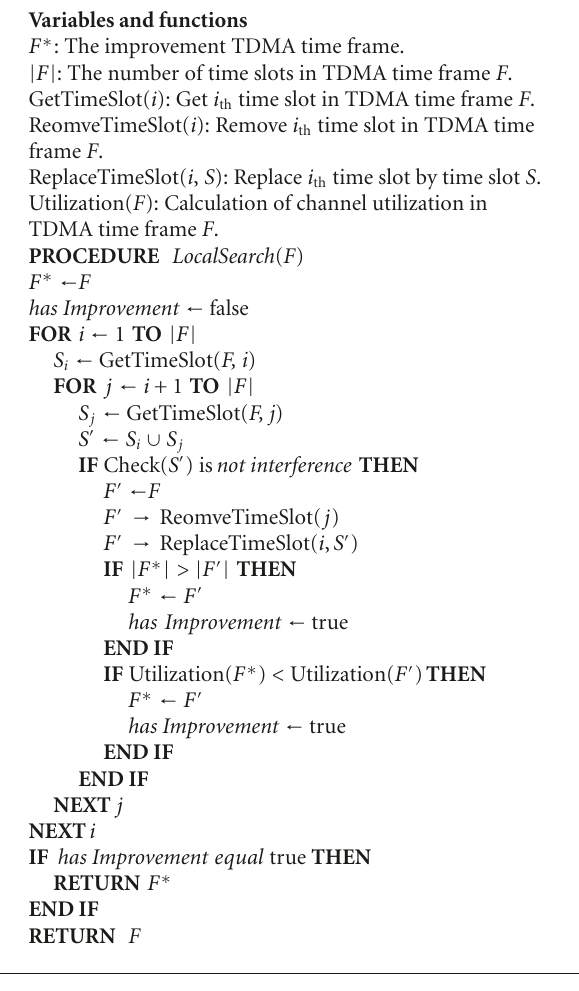
Figure 1: A seven-node